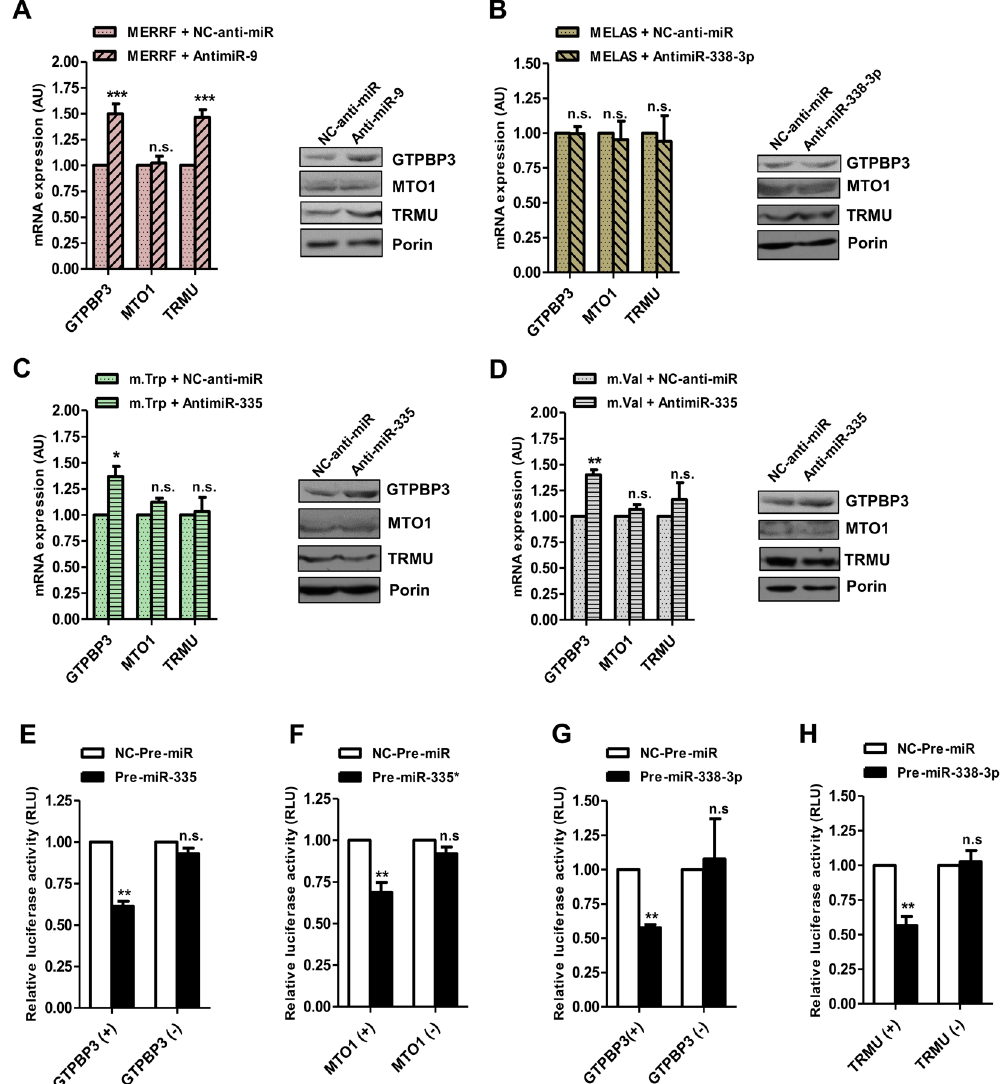
Figure 5. miR-9/9 * , miR-338-3p, and miR-335/335 * are regulators of the U34 modification enzymes. (A–D) qRT-PCR (left) and Western blot (right) analysis of GTPBP3, MTO1 and TRMU expression in anti-miR- 9-transfected MERRF cells ( A ), anti-miR-338-3p-transfected MELAS cells ( B ), anti-miR-335-transfected m.Trp cells ( C ) and anti-miR-335-transfected m.Val cells ( D ), and in the respective negative control (NC)-transfected cells ( A–D ). Full-length western blots are included in supplementary information. (E) Effects of miR-335 transfection on the activity of luciferase reporter constructs containing the GTPBP3-3 ′ -UTR in the direct ( + ) or reverse ( − ) direction. ( F ) Effects of miR-335 * transfection on the activity of luciferase reporter constructs containing the MTO1-3 ′ -UTR in the direct ( + ) or reverse ( − ) direction. ( G and H ) Effects of miR-338-3p transfection on the activity of luciferase reporter constructs containing the GTPBP3-3 ′ -UTR ( G ) and TRMU- 3 ′ -UTR ( H ) in the direct ( + ) or reverse ( − ) direction. All data are the mean ± SEM of at least three different experiments. Differences from NC values were found to be statistically significant at * p < 0.05, ** p < 0.01 and *** p < 0.001. RLU: Relative light